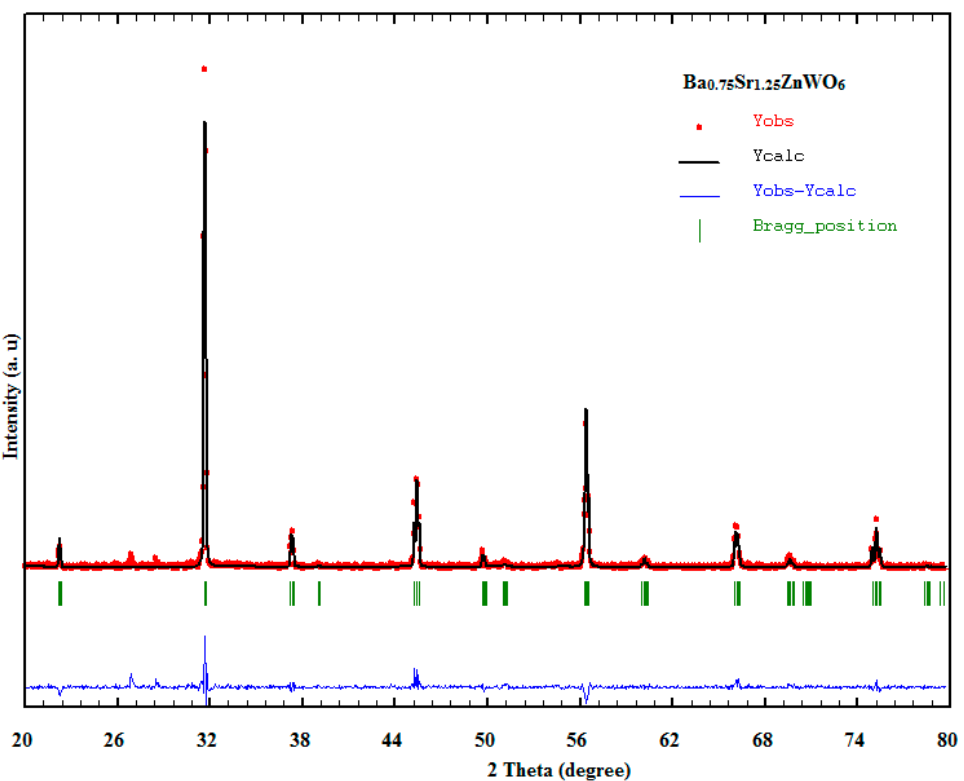
Figure 2. Rietveld refined XRD pattern of the Ba 0.75 Sr 1.25 ZnWO 6 sample.